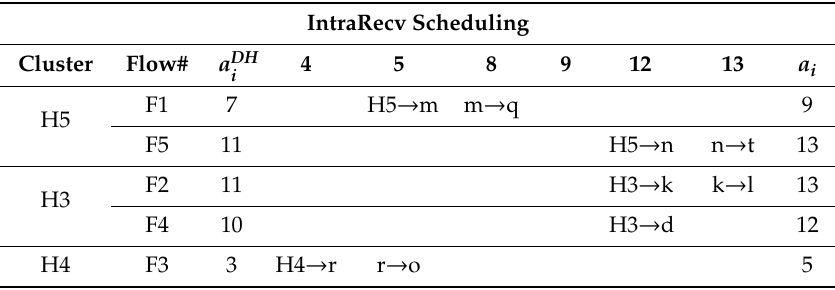
Table 6. Results of proposed scheme IntraRecv scheduling of Figure